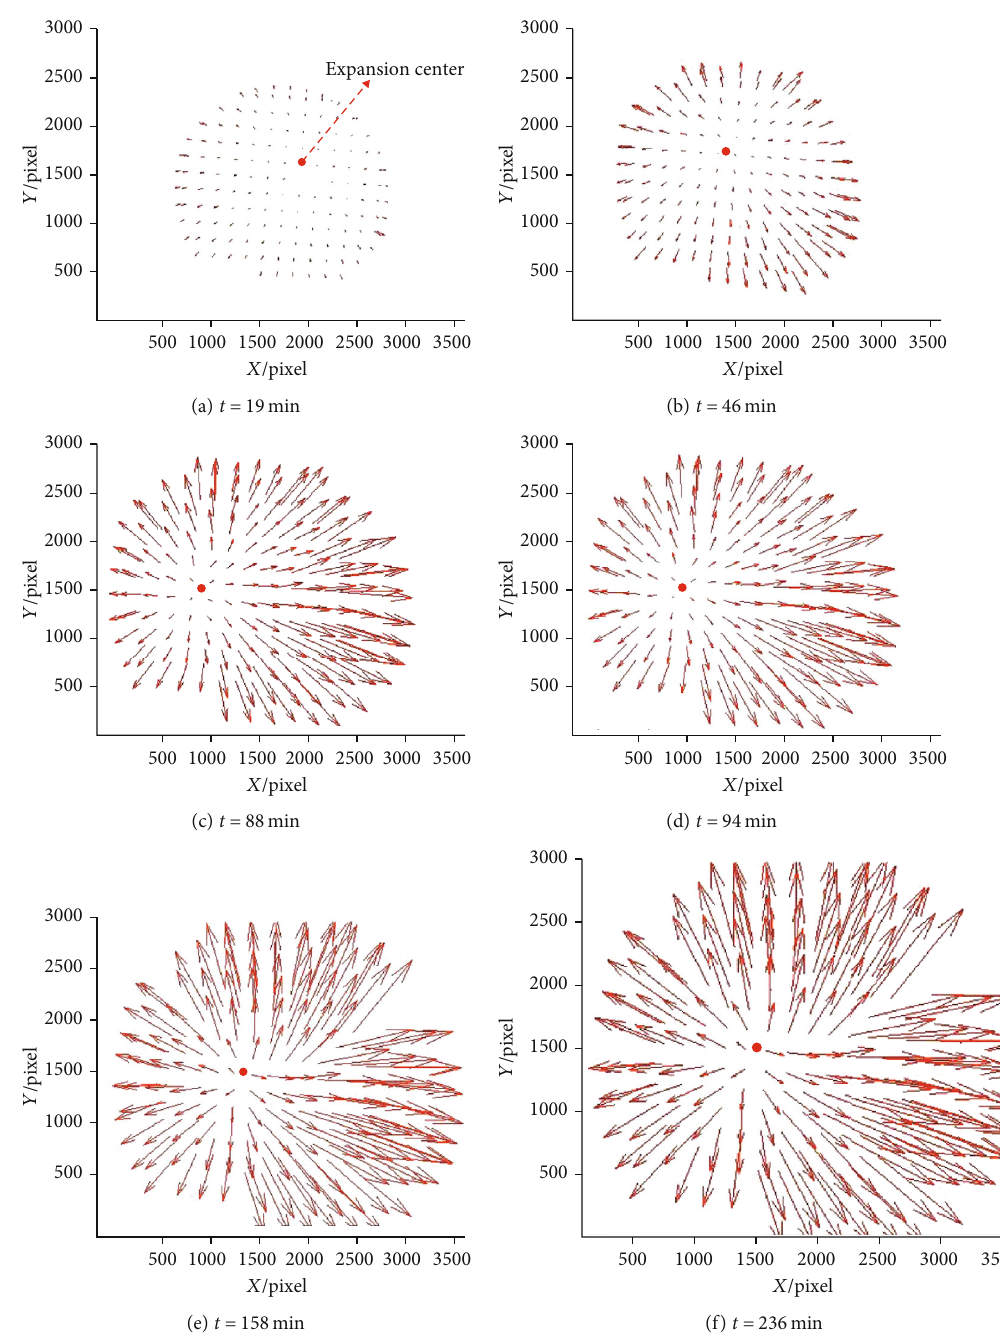
Figure 16: Displacement vector graph in di ff erent times of 2#